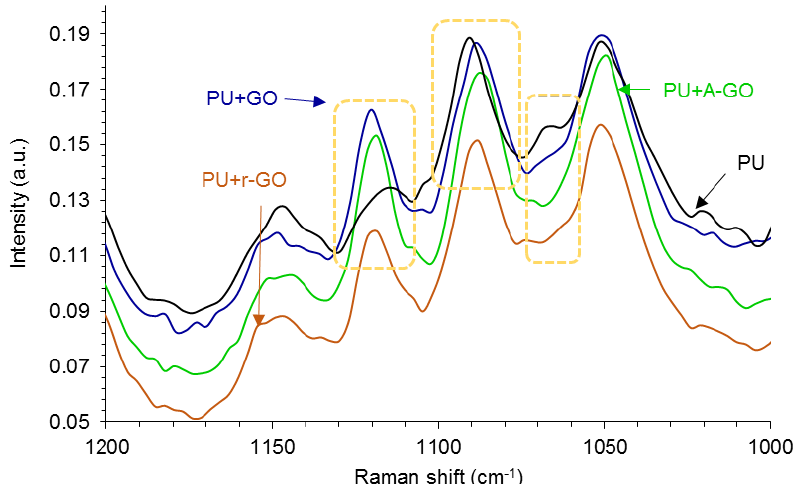
Figure 11. 1200 – 1000 cm −1 region of the Raman spectra of the PUs without and with GO derivatives. The DSC traces corresponding to the second heating runs of the PUs are shown in Figure S5 of the Supplementary Materials file, and the thermal events in the DSC traces are given in Table 7. The PU without GO derivative shows the glass transition tempera- tures (T g s) of the soft segments at − 53 °C and 5 °C, and the T g of the hard segments at 193 °C. The addition of the GO derivative slightly increases the T g of the soft segments and decreases the T g of the hard segments (Table 7), this indicates lower degree of micro-phase separation which is somewhat more marked in PU+r-GO. Moreover, one melting peak at 45 °C of the soft segments appears only in PU+A-GO, because of its higher percentage of soft segments evidenced by ATR-IR spectroscopy — this indicates different interactions than in the other PUs. As a result, the addition of the GO derivative with different surface functionality changes differently the degree of the micro-phase separation in the PU. Table 7. Thermal events obtained from the DSC traces of the PUs. Second heating run. Poly(Urethane Urea)